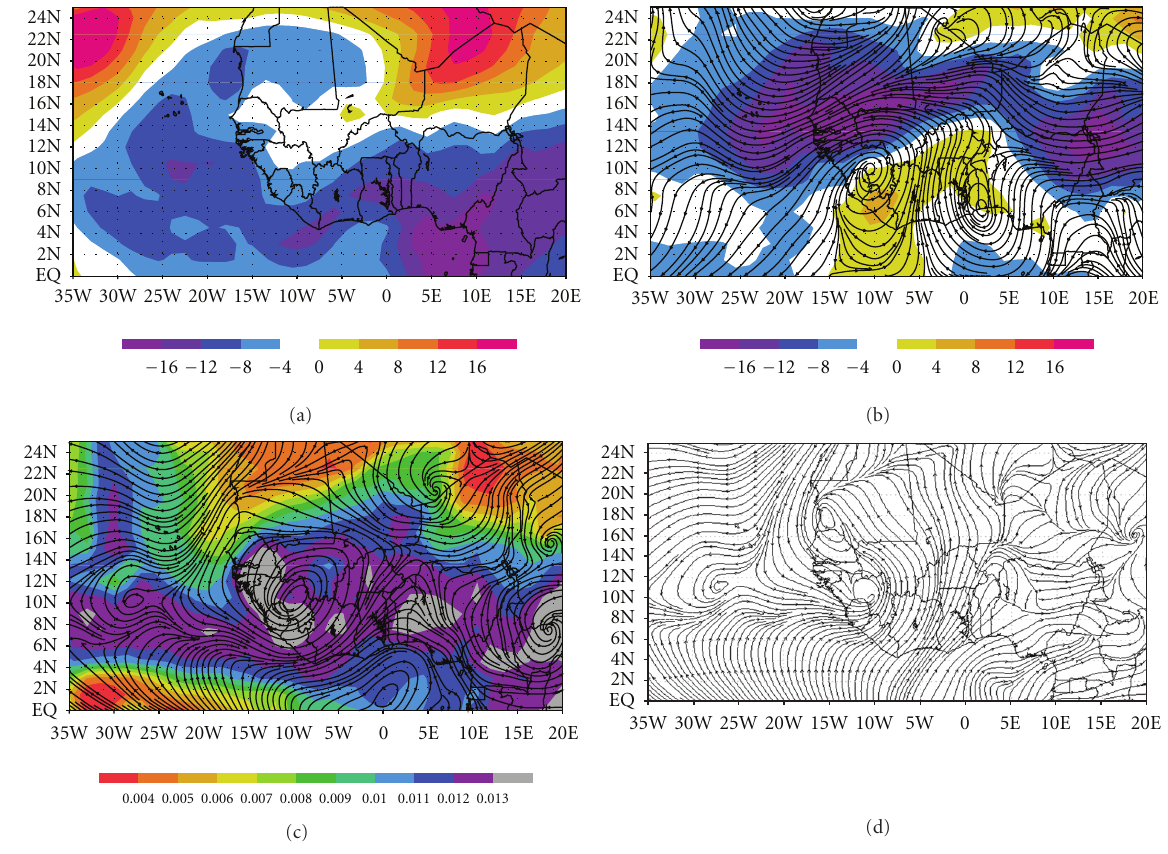
Figure 3: (a) ECMWF Reanalysis zonal winds (ms − 1 ) at 0000 UTC 11 September for 200hPa. (b) Composite ECMWF Reanalysis zonal winds (ms − 1 ) and streamlines at 0000 UTC 11 September for 650 hPa. (c) Composite ECMWF Reanalysis specific humidity (kgkg − 1 ) and streamlines at 0000 UTC 11 September for 850 hPa. (d) ECMWF Reanalysis streamlines at 0000 UTC 11 September for